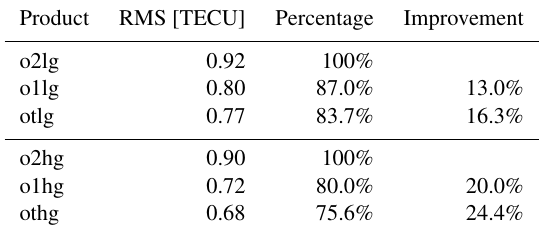
Table 3. Relative improvements (in percentage) for a downsizing of the sampling interval of the “o2lg”, “o1lg”, “otlg”, “o2hg”, “o1hg” and “otlg” products.